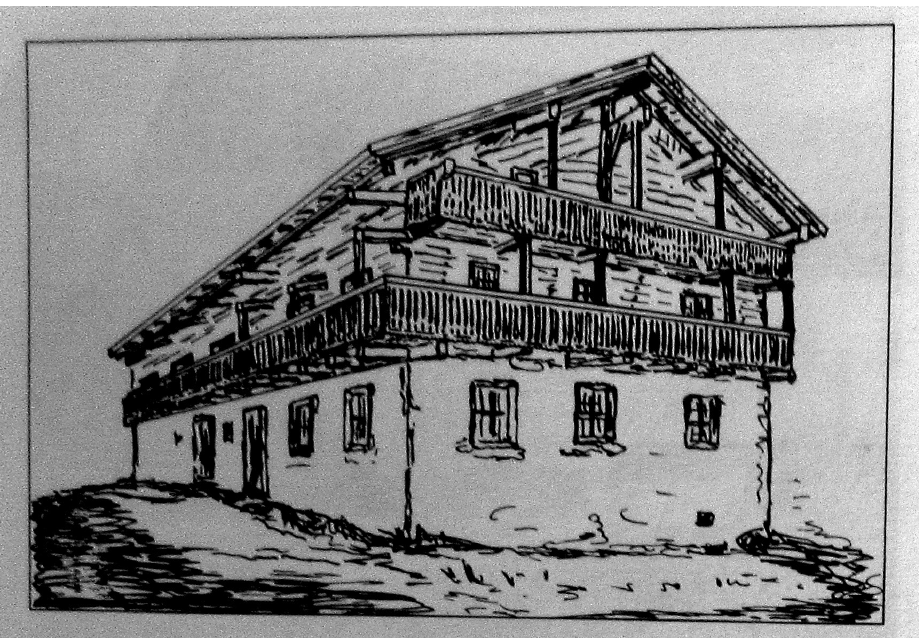
Figure 1: Drawing of Irlbeck’s house which was moved to the farming museum in Tittling in 1985 in: Merz, Museumsdorf,